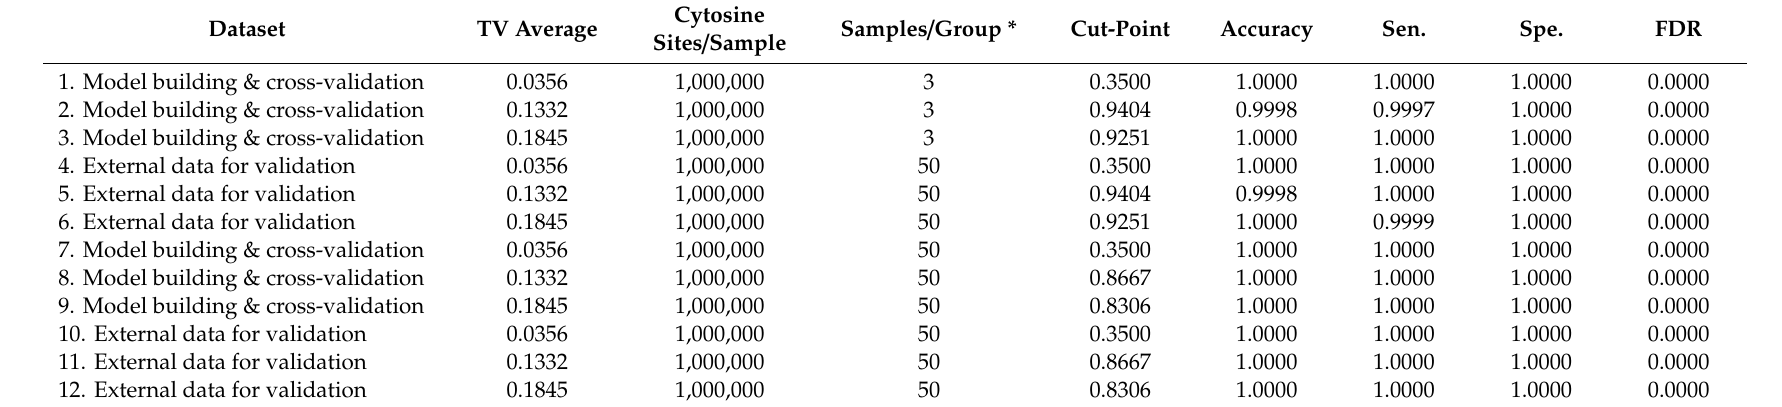
Table 1. Summary of the datasets generated for simulation